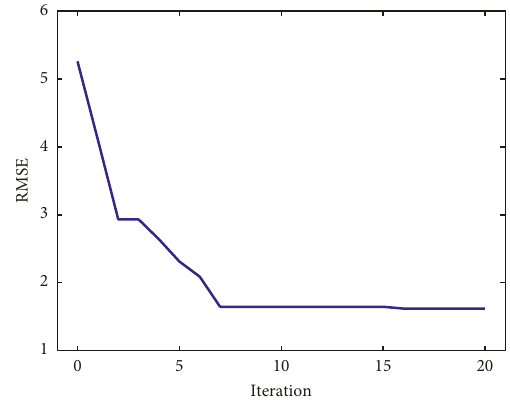
Figure 4: RMSE versus iterations. Table 2: The obtained hyperparameters of